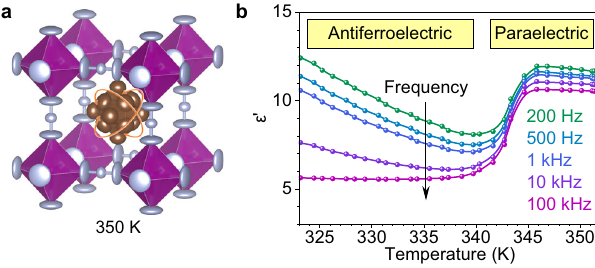
Fig. 5 High-temperature structure and dielectric behavior of AthMn(N 3 ) 3 . a Thermal ellipsoid model of AthMn(N 3 ) 3 in the high-temperature phase at 350 K, where the Ath + cage cation tumbles freely. b Temperature and frequency dependence of the dielectric constant ε ′ of AthMn(N 3 ) 3 , showing a transition from antiferroelectric to